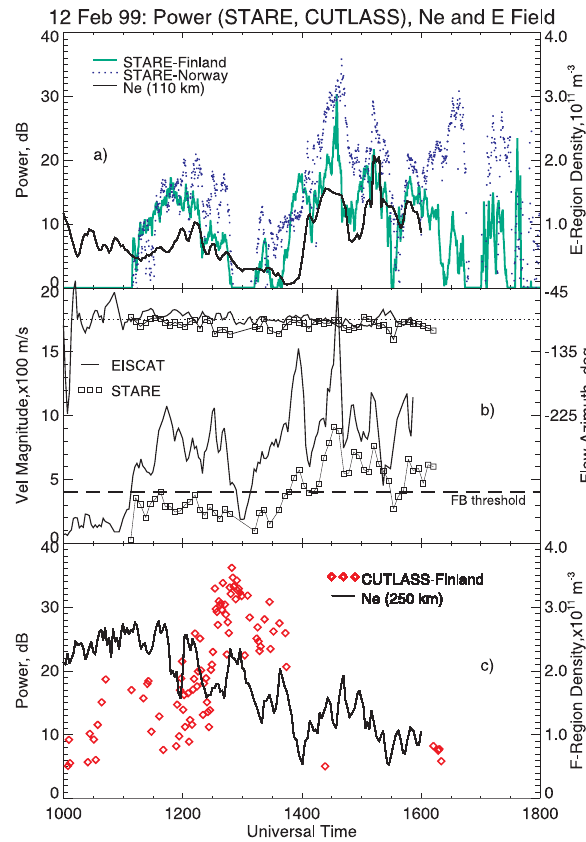
Fig. 4. (a) Temporal variations of Finland STARE (green dots) and Norway STARE (blue dots) echo power in bins 27 and 17, re- spectively. Power of the Norway radar was scaled down by 2.4dB to take into account the shorter distance to the scattering volume. Solid line shows the electron density at 110km according to EIS- CAT measurements. (b) Plasma convection velocity magnitude and azimuth according to EISCAT tri-static measurements at 250km (solid line) and STARE convection magnitude/direction estimates (squares). (c) The Hankasalmi CUTLASS echo power (red dia- monds) versus time and the electron density at 250km according to EISCAT